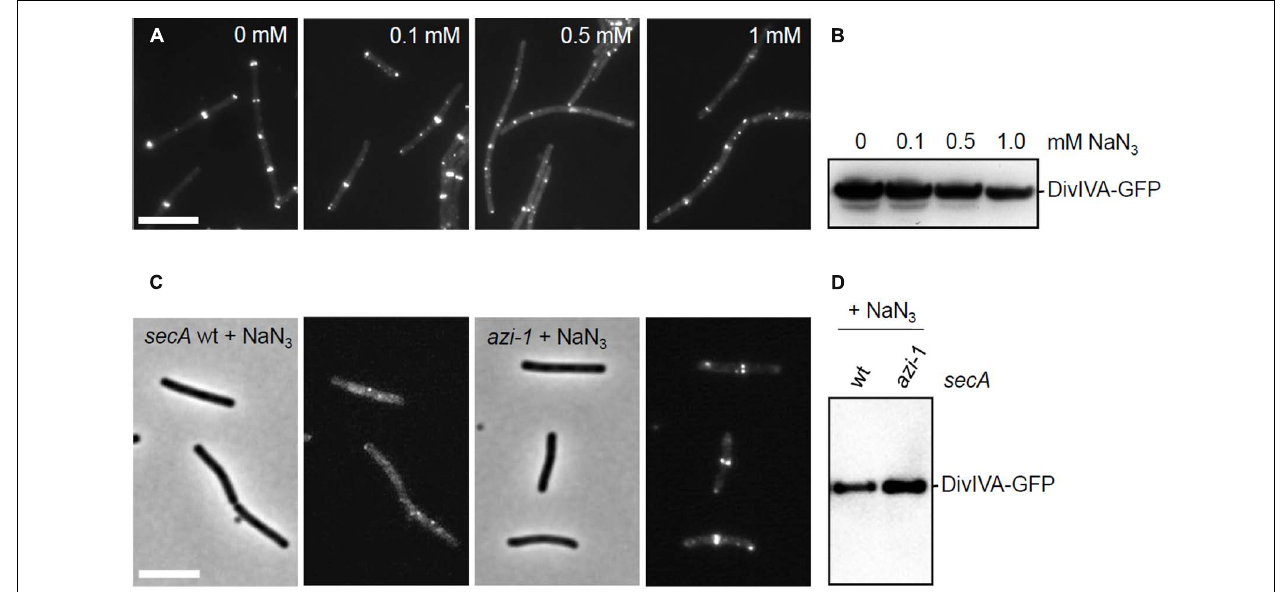
FIGURE 6 | Effect of azide on the localization of DivIVA-GFP. (A) Fluorescence micrographs showing the localization of DivIVA-GFP in strain 4067 pretreated with increasing amounts of sodium azide. (B,D) Western blot analyses to assess the stability of DivIVA-GFP